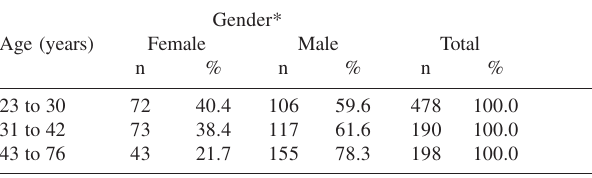
Table 1 - Sample description by age and